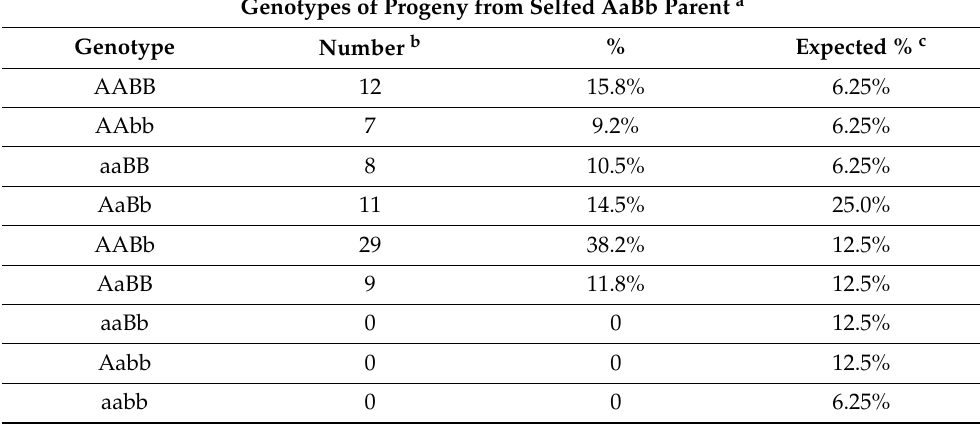
Table 1. pbe1 pbe2 Double Mutants Are